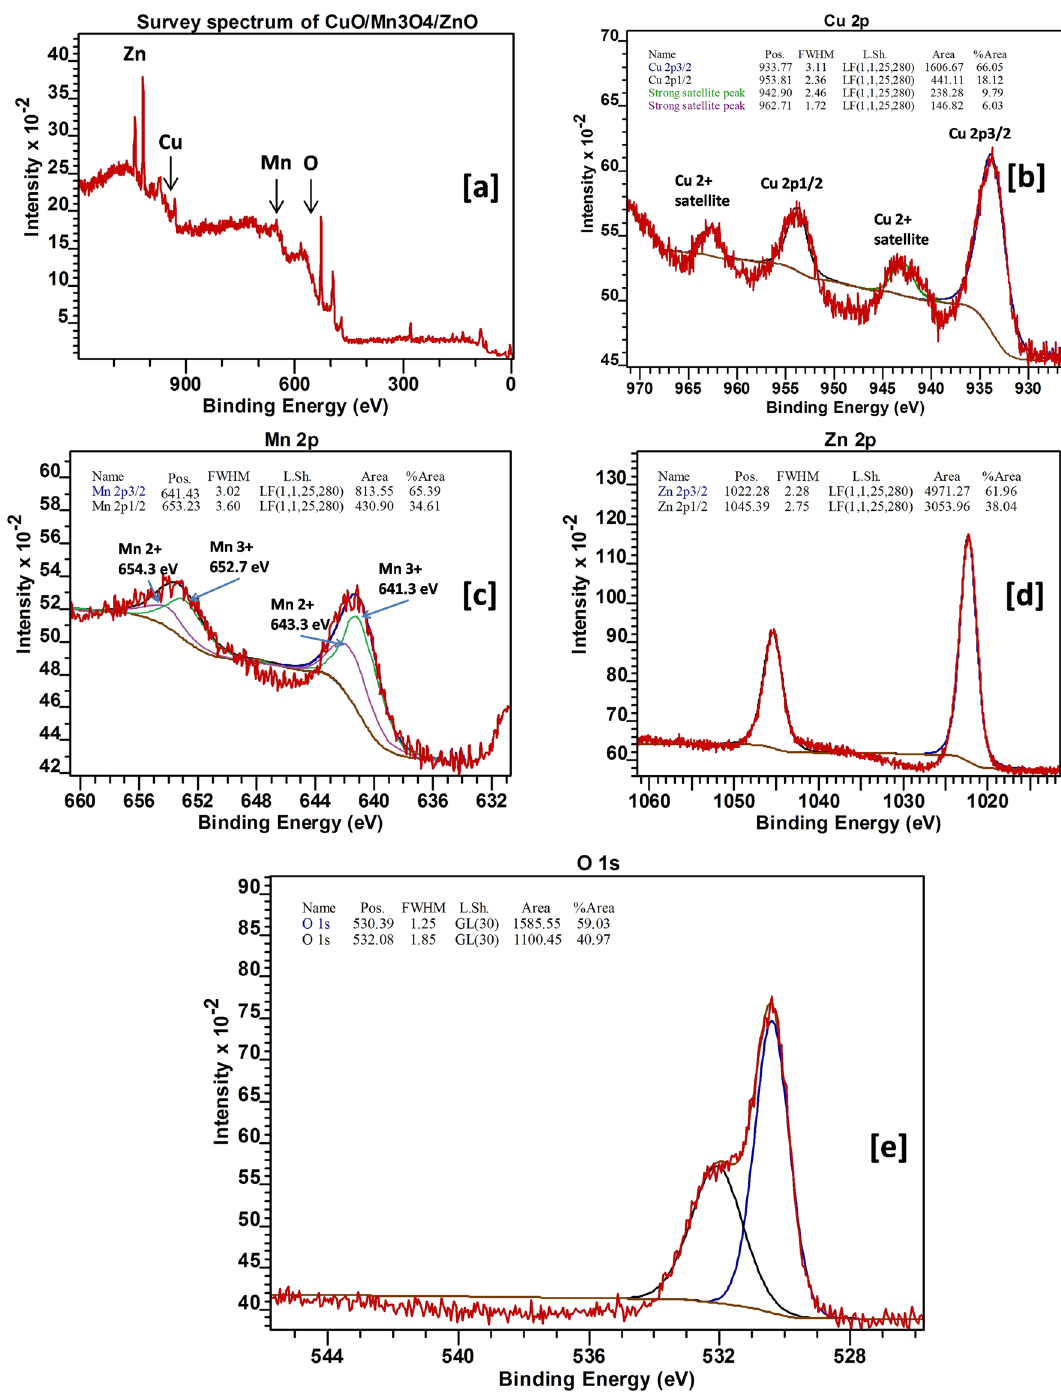
Figure 3. ( a ) XPS survey spectrum of CuO/Mn 3 O 4 /ZnO and HR-XPS spectra of ( b ) Cu, ( c ) Mn, ( d ) Zn and ( e ) O in the final